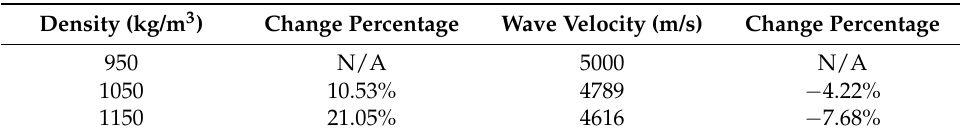
Table 7. Parametric study of density for orthotropic model.